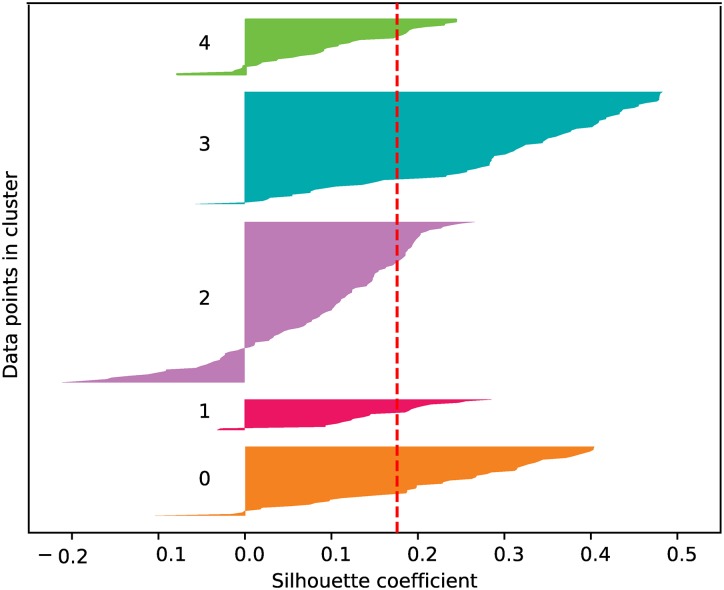
Silhouette plot for each data point categorized
into clusters.The dashed line indicates the average silhouette of 0.18.